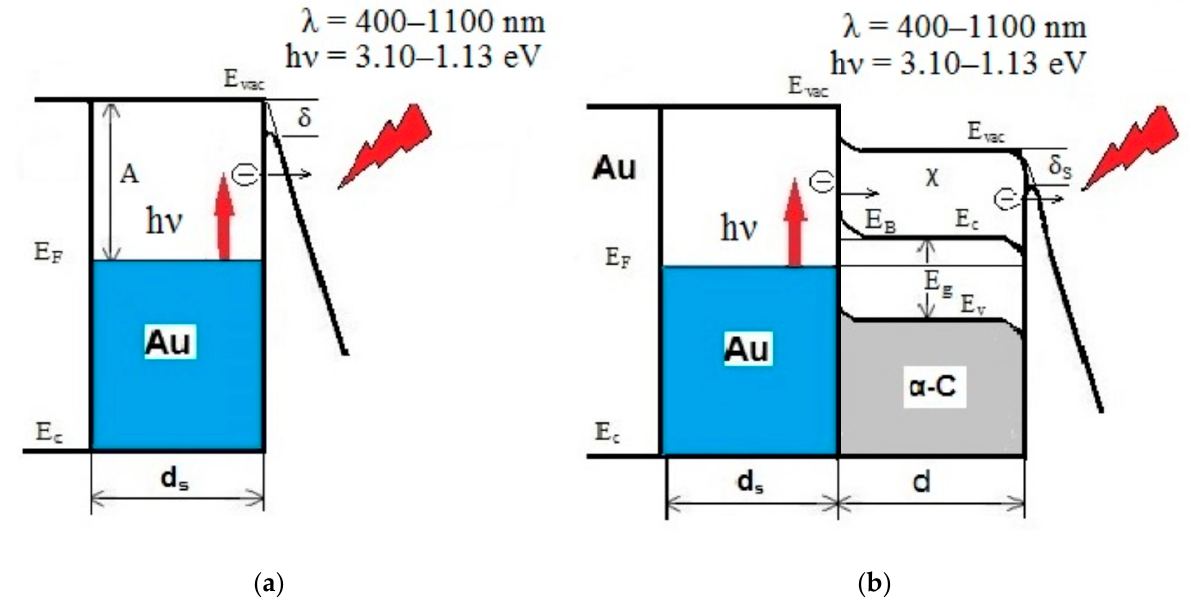
Figure 1. Diagram of the energy levels of a gold nanoparticle ( a ) and a hybrid material—gold nanostars (GNS), embedded into a diamond–like carbon (DLC) film ( b ) in a strong electrostatic field F under irradiation with light in the visible or NIR range.